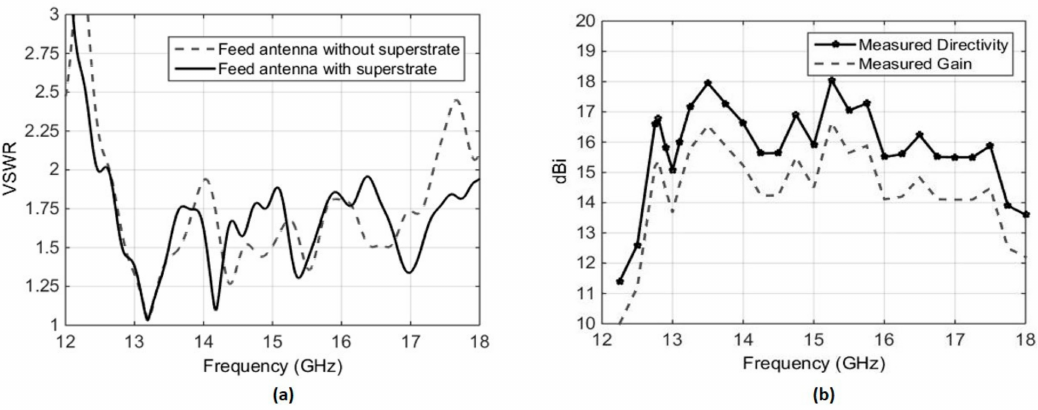
Figure 8. Measured results of the RCA with planar feed antenna, ( a ) VSWR of the antenna with and without PRS, ( b ) broadside directivity and realized gain.